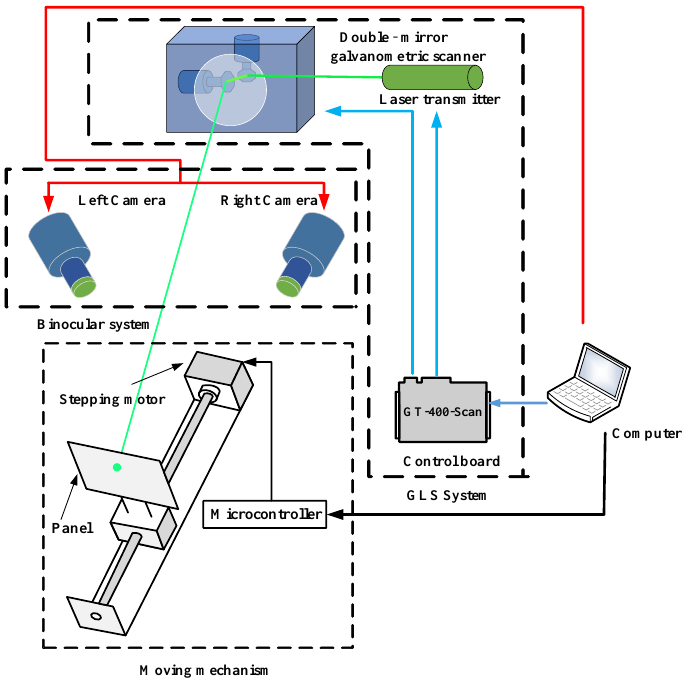
Figure 1. System calibration configuration.